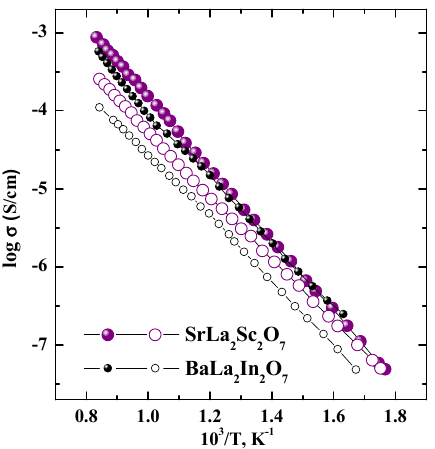
Figure 5. Temperature dependencies of conductivity for SrLa 2 Sc 2 O 7 composition obtained under dry (filled symbols) and wet (open symbols) conditions.